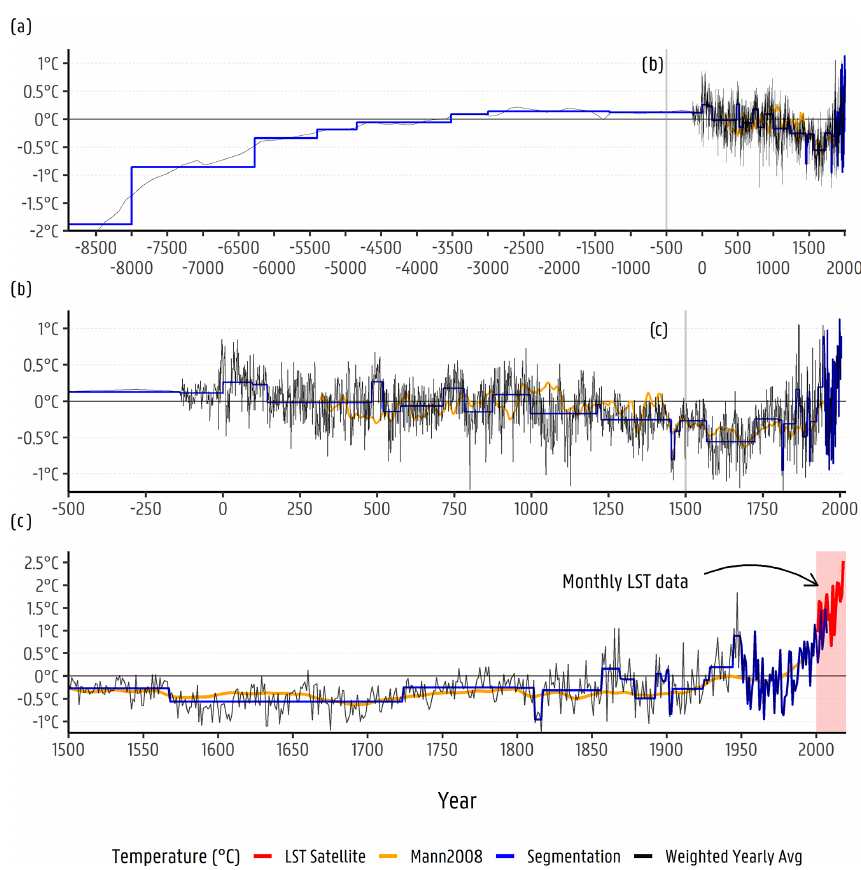
Figure 3. Temperature–time curve to use as input in a transient heat transport simulation indicating the time step sizes for the last 10519